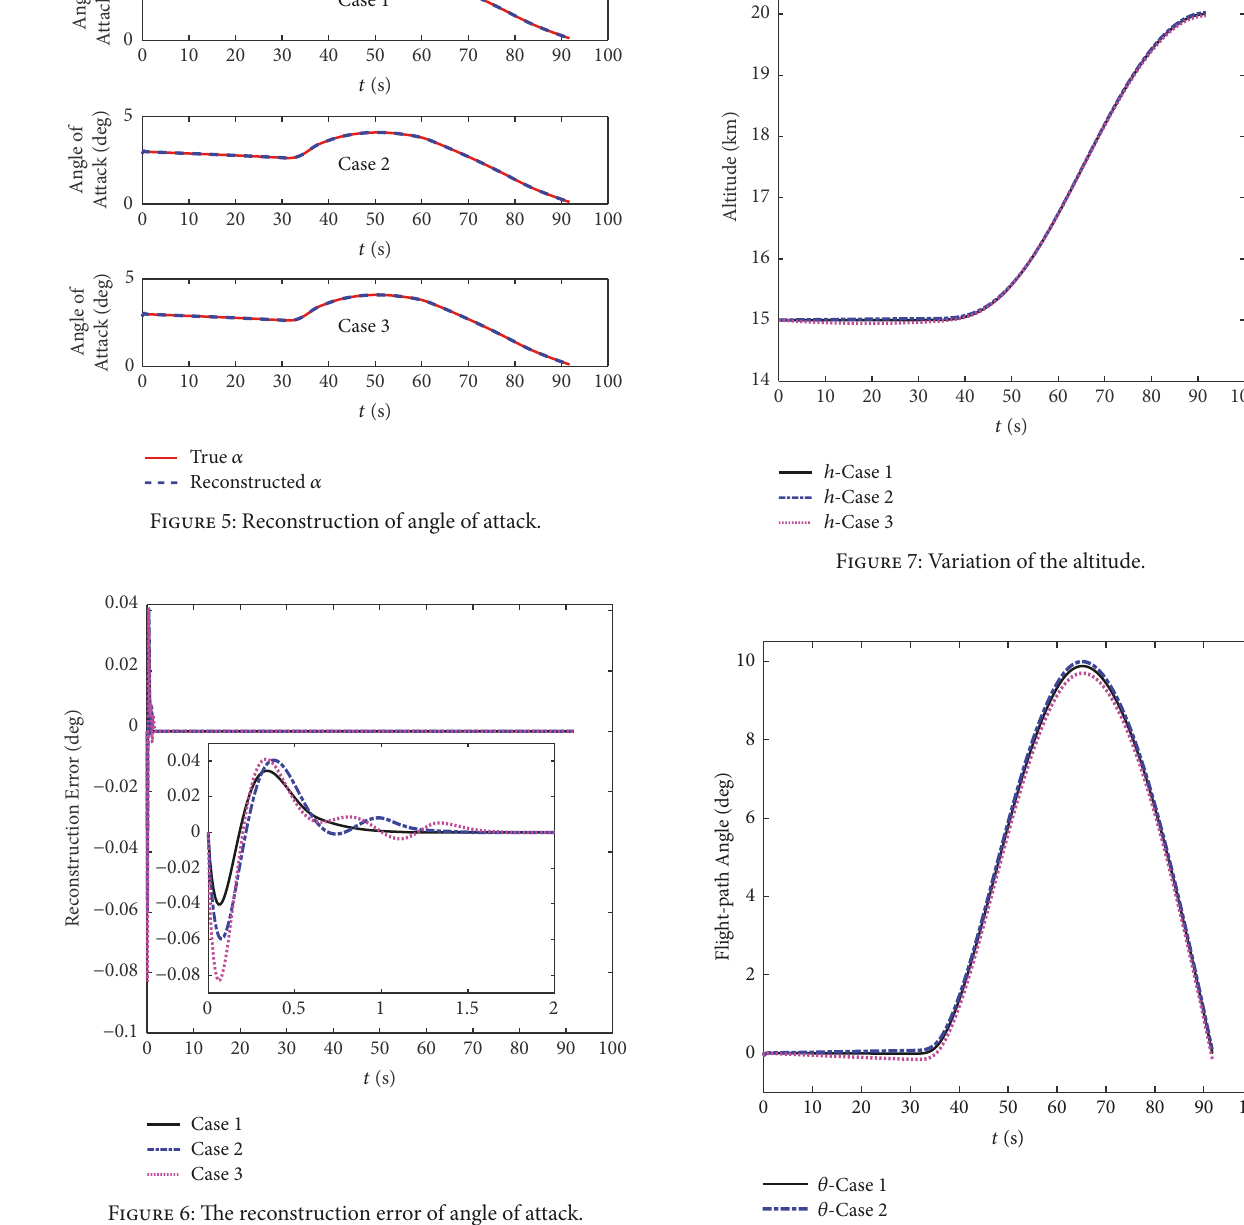
Figure 8: Variation of the flight-path